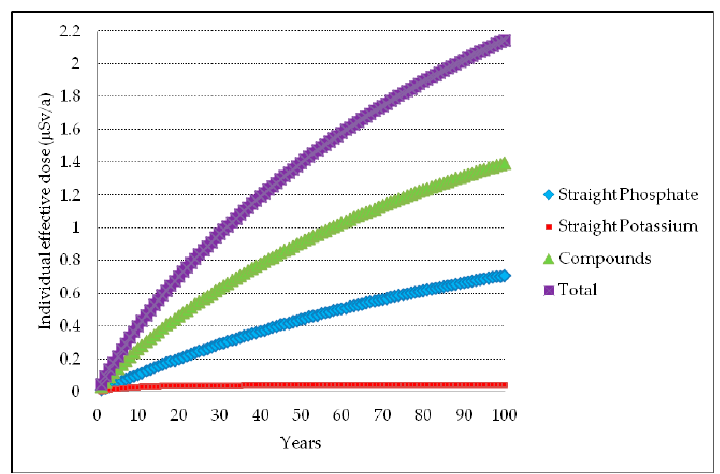
Figure 3. Trend of the annual individual effective dose (µSv/a) due to continuous spreading (100 years) on the same agricultural area, for single fertilizer.